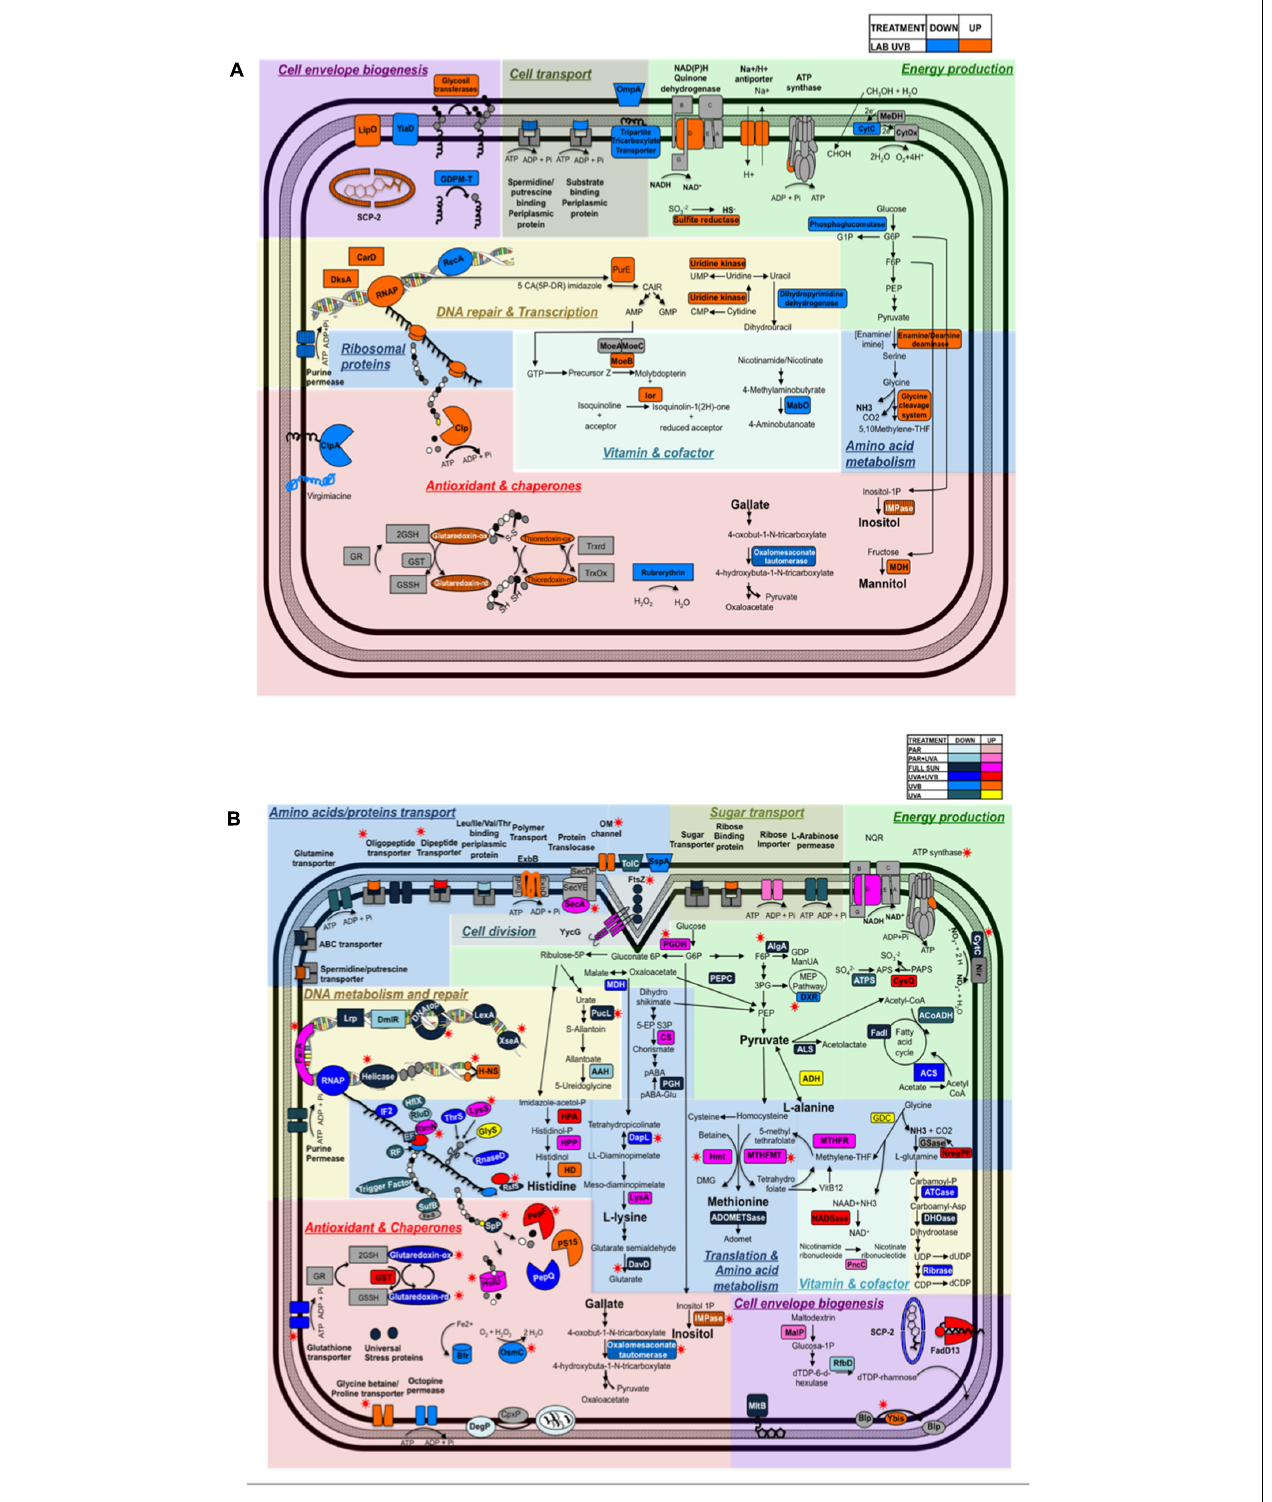
FIGURE 6 | Diagram depicting the cellular pathways impacted by (A) Artificial UVB treatment and (B) Natural light conditions (Full Sun, PAR, PAR+UVA, UVA+UVB, UVB, UVA) in Rhodobacter sp. The up and down-regulated proteins are represented according to the color code provided at the top right corner of the diagram. Striped boxes represent proteins shared by Artificial UVB treatment and Natural light treatments. Red stars indicate proteins shared by more than one condition within among all natural light treatments.